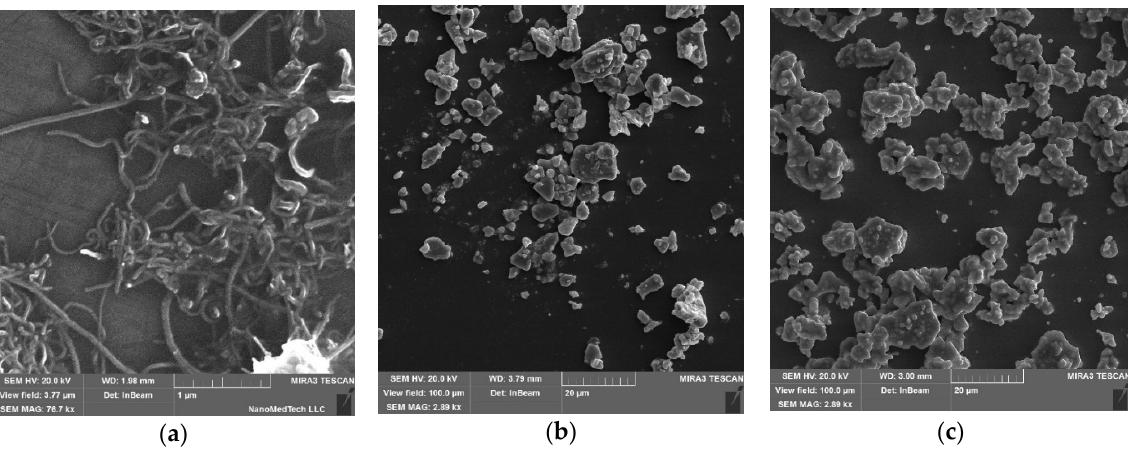
Figure 1. SEM images of multi-walled carbon nanotubes ( a ) and BaFe 12– x Ga x O 19 powders: ( b ) x = 0.3; ( c ) x = 0.9.